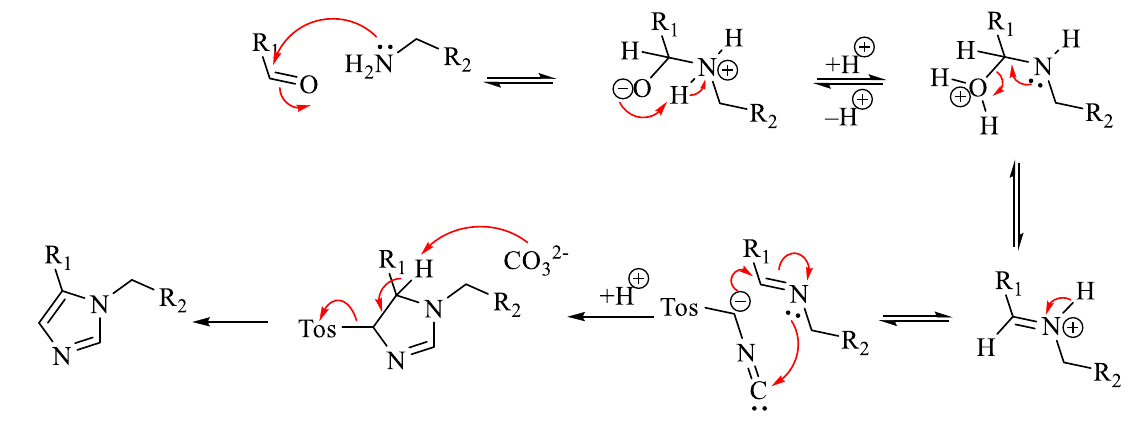
Scheme 2. Proposed reaction mechanism of Van Leusen three-component reaction.